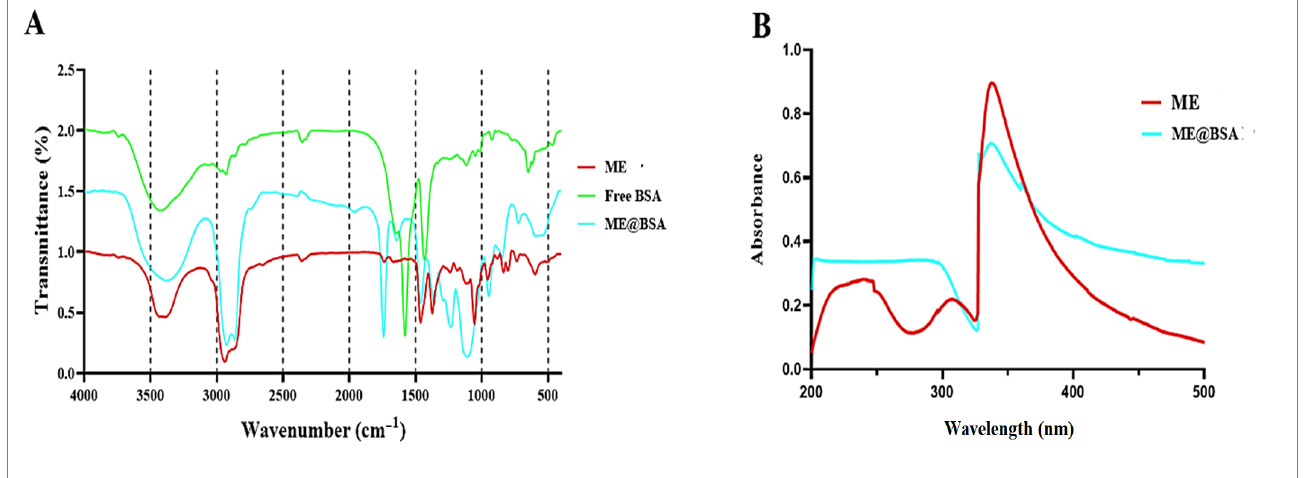
Figure 3. ( A ) FT-IR spectra of ME, free BSA, and ME@BSA, and ( B ) UV-Vis spectroscopy of the prepared microemulsion systems, ME and ME@BSA.